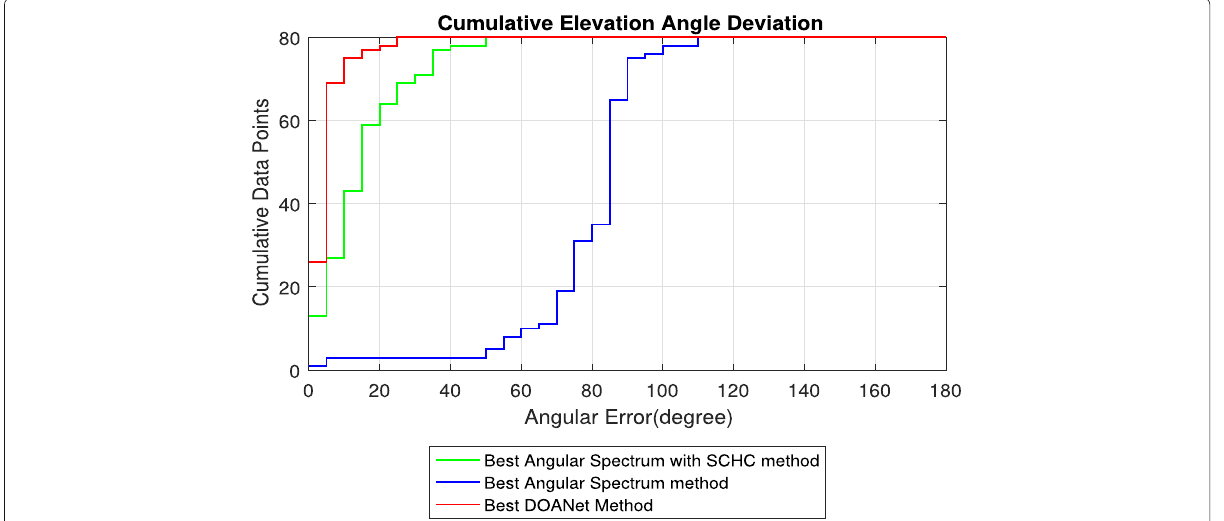
Fig. 12 AUCs for cumulative in-flight elevation angle